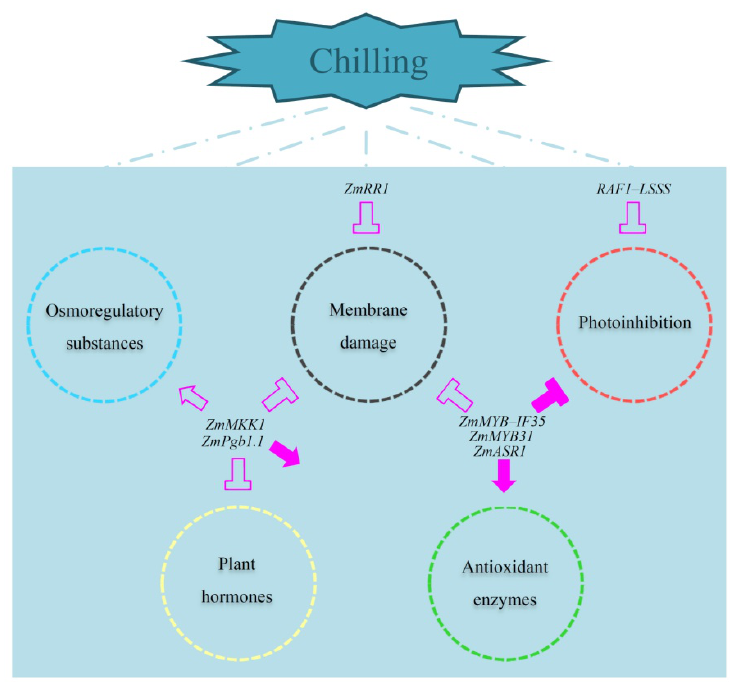
Figure 3. Published genes involved in the changes in terms of osmoregulatory substances, membrane damage, photoinhibition, plant hormones and antioxidant enzymes under chilling stress.